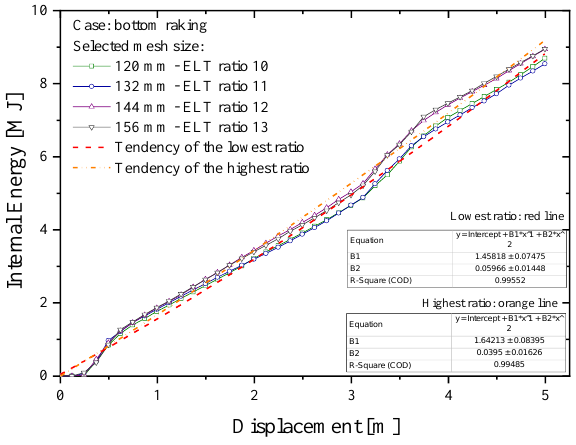
Figure 8. Results of the internal energy for various applied mesh sizes. Notable differences were Figure 8: Results of the internal energy for various applied mesh observed in the transition from a mesh size of 132 mm (ELT ratio of 11) to 144 mm (ELT ratio of sizes. Notable differences were observed in the transition from a 12). mesh size of 132 mm (ELT ratio of 11) to 144 mm (ELT ratio of 12)